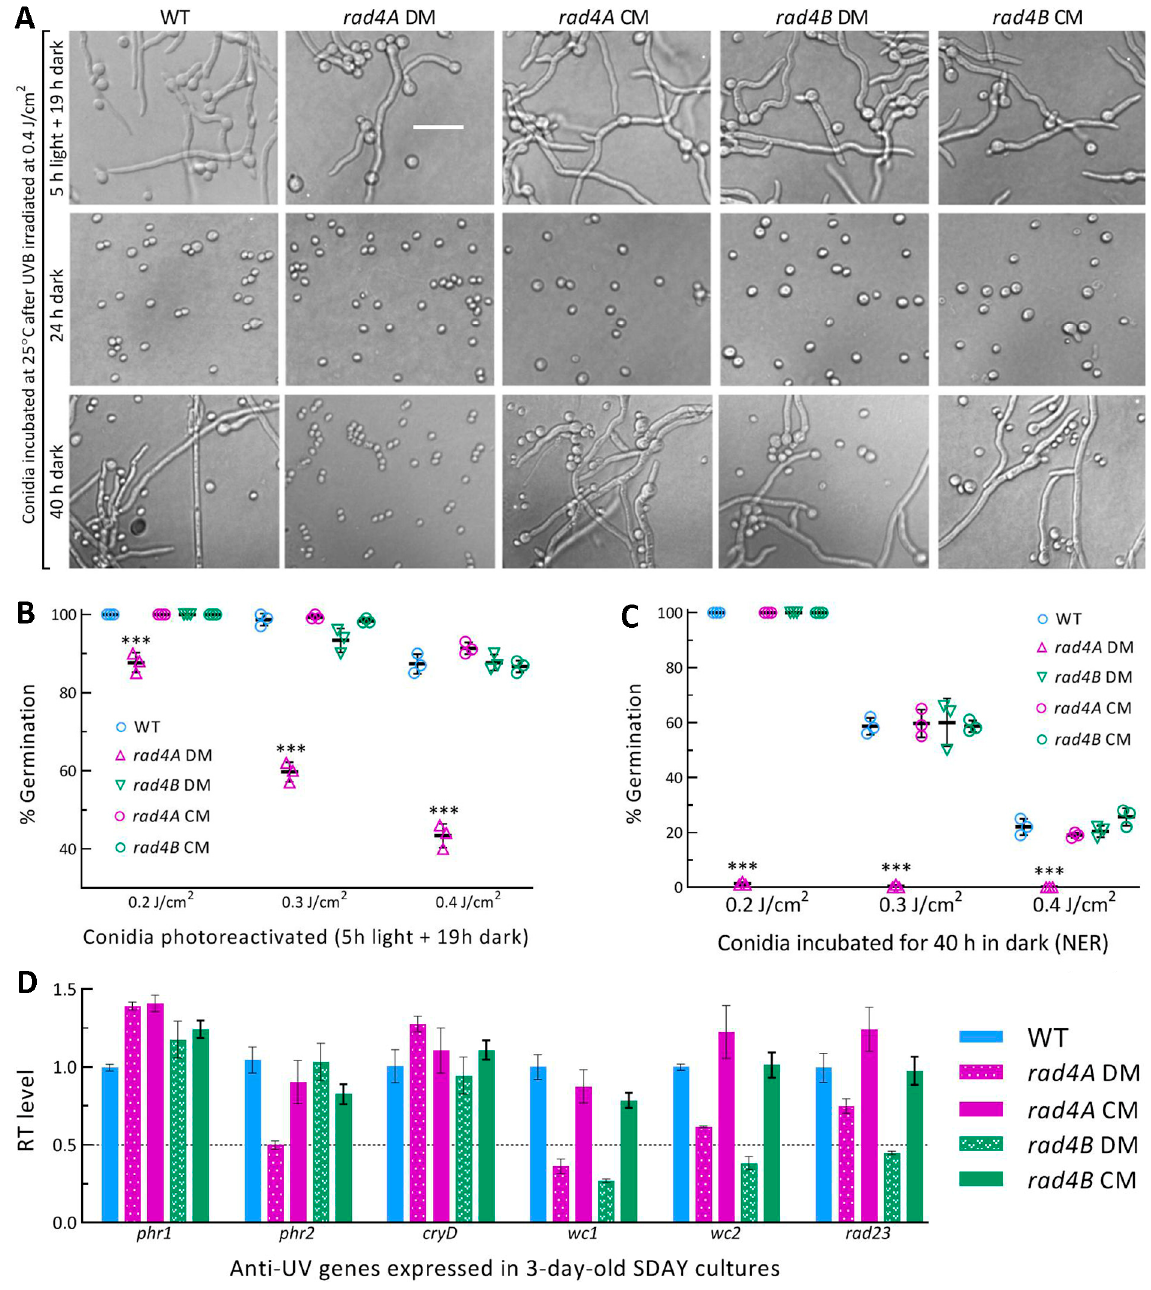
Figure 4. Essential role of Rad4A versus null role of Rad4B in photoreactivation of UBV-impaired conidia in B. bassiana . ( A ) Microscopic images (scale: 20 μ m) for conidial germination status of disruption mutants (DMs) and control (CM and WT) strains incubated at 25 °C for 5 h under white light plus 19 h in the dark (photoreactivation) or directly for 24 and 40 h in the dark (NER) after exposure to the UVB dose of 0.4 J/cm 2 . ( B , C ) Germination percentages of the tested strains’ conidia photoreactivated at 25 °C for 5 h or reactivated by 40 h dark incubation (NER) at 25 °C after expo-